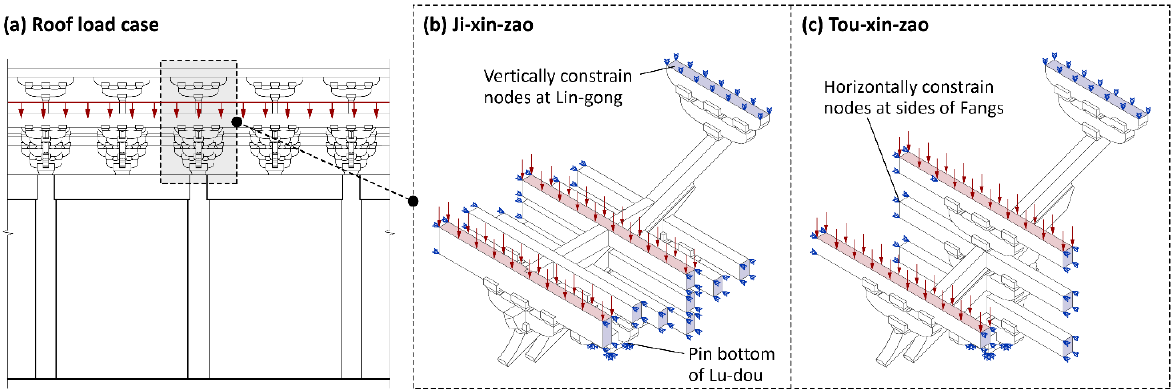
Figure 6. Load and boundary definitions of the two finite element models corresponding to the roof load condition. ( a ) Roof load case; ( b ) Ji-xin-zao; ( c ) Tou-xin-zao.